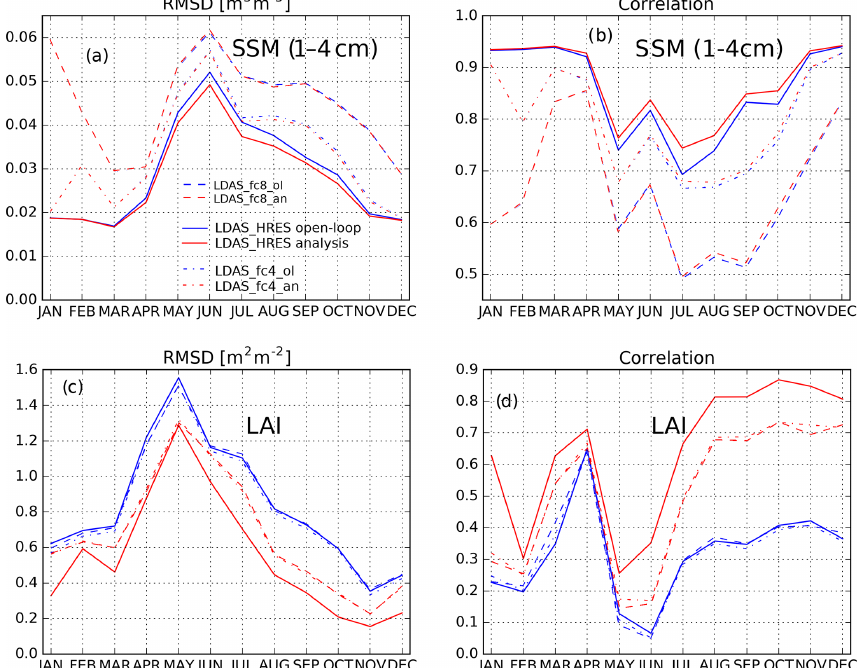
Figure 12. Seasonal (a) RMSD and (b) correlation values between soil moisture from the second layer of soil (1–4cm) from the model forced by HRES (LDAS_HRES, open-loop in blue solid line, analysis in red solid line) and ASCAT SSM estimates over 2017–2018 over the WEUR area. Scores between SSM from the second layer of soil of LDAS_HRES, 4d (dashed/dotted blue – when initialized by the open-loop – and red – when initialized by the analysis – lines) and 8d (dashed blue and red lines) forecasts and ASCAT SSM estimates are also reported. Panels (c) and (d) : same as (a) and (b) between modelled/analysed LAI and GEOV1 LAI estimates.